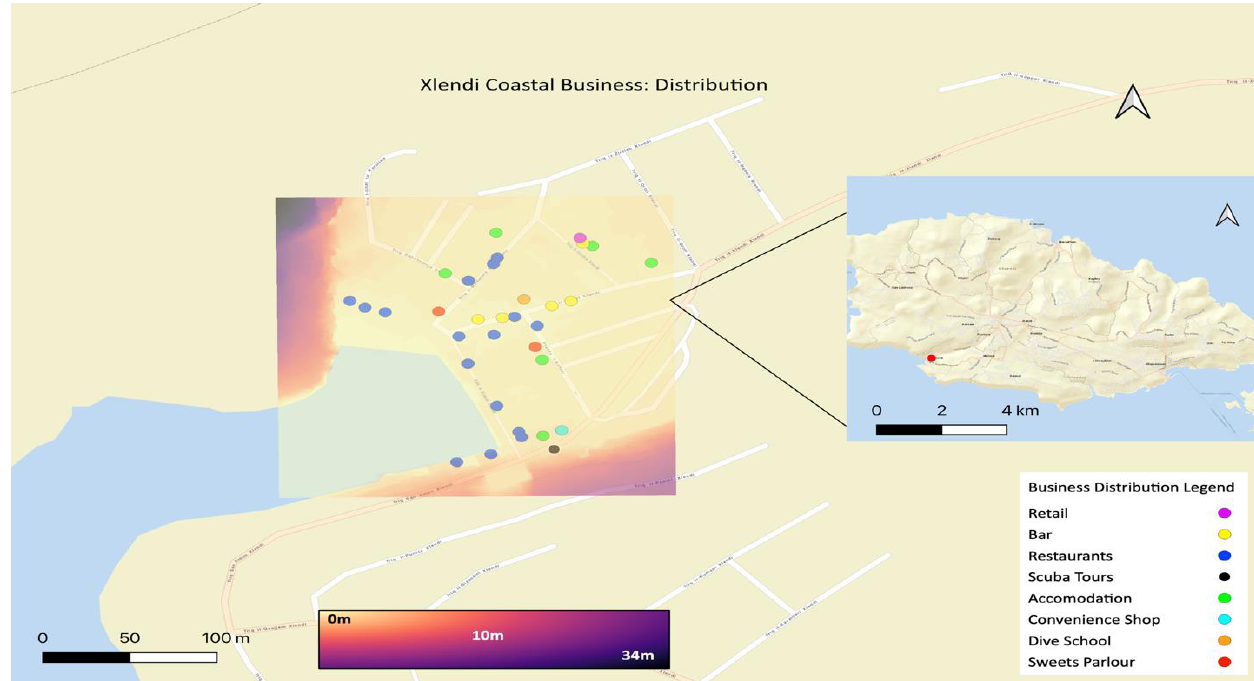
Figure 12 . Xlendi’s coastal businesses’ distribution.